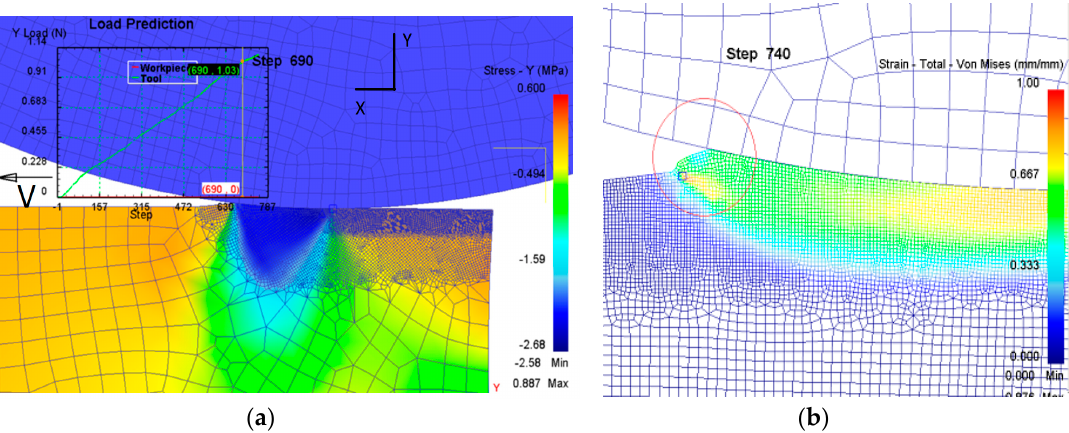
Figure 8. ( a ) Dependence of the relative pressure by Equation (35) (yield stress = 1 MPa) during finite elements simulation of wide burnishing by indenter R = 4 mm at t = 0.009 mm; ( b ) bulge forming in front of the indenter (R = 2 mm, t = 0.008 mm).